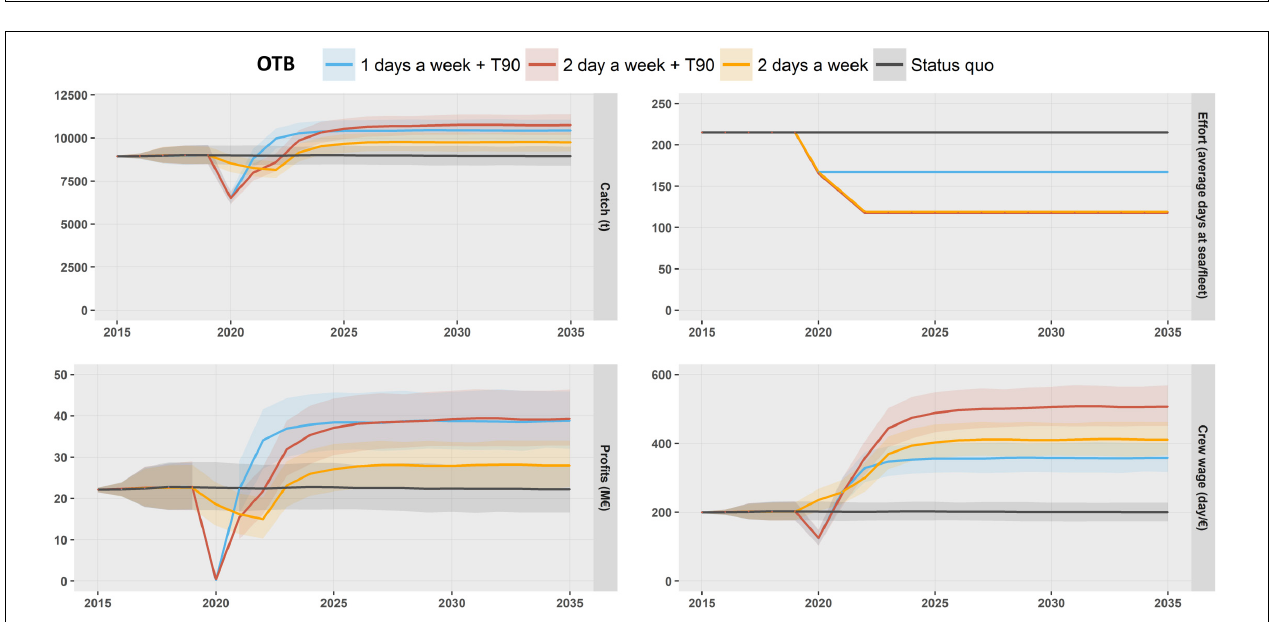
FIGURE 9 | Results of the bioeconomic model of catch (tn), fishing mortality (F 1 − 3 ), SSB (tn), and constant recruitment for M. merluccius under historical series and Scenario 0: status quo , Scenario 3: selectivity change to T90, Scenario 4: selectivity change plus 10% annual reduction over 4 years; and Scenario 5: selectivity change plus 20% annual reduction over 4 years. Dashed lines indicates the FMSY level and SSBlim (computed as SSBlim = 1.4*SSBmin , where SSBmin is the minimum value of SSB observed in the historical data series).